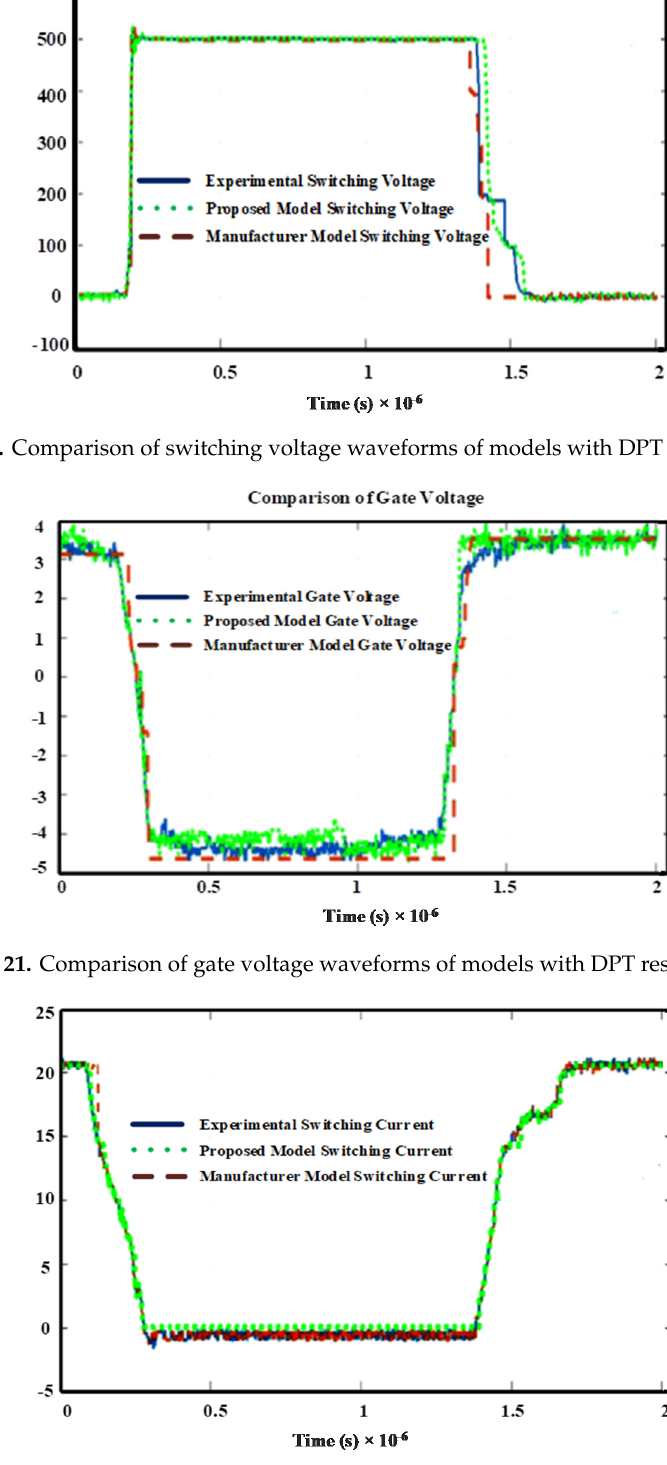
Figure 22. Comparison of switching current waveforms of models with DPT results.